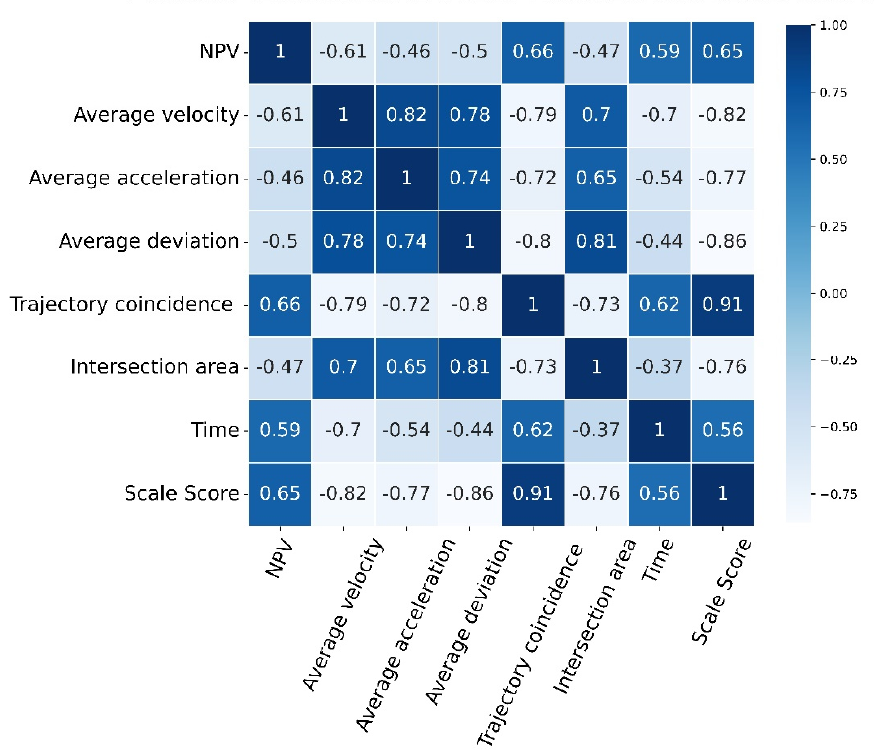
Figure 5. Heat map of Pearson’s correlation analysis between motor features and clinical doctors’ scale score.